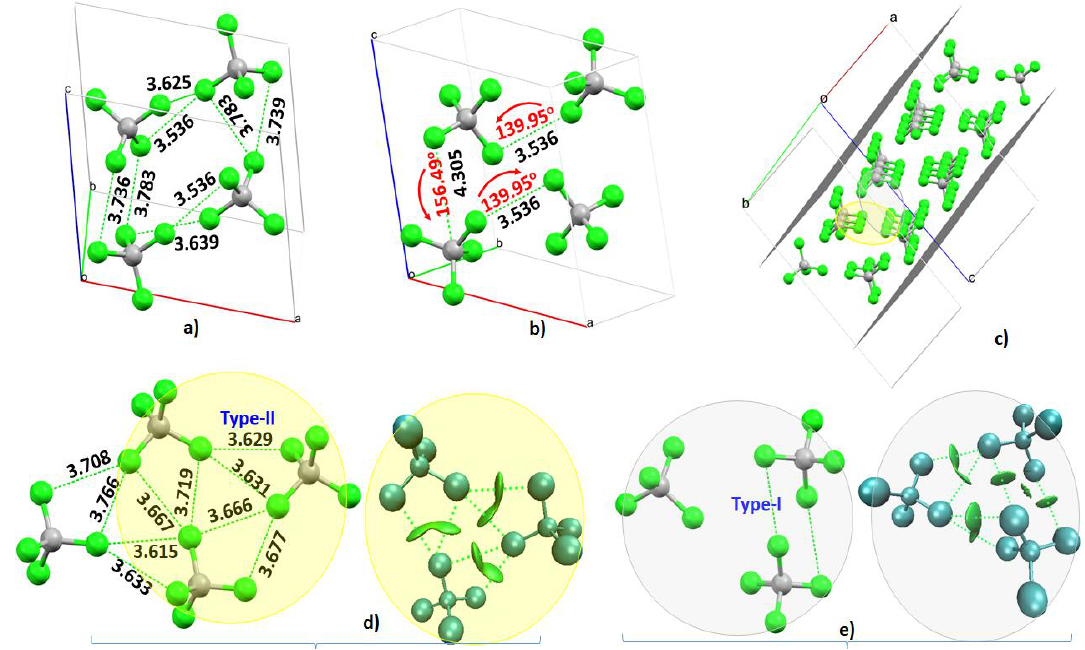
Figure 11. The ball-and-stick models of the ( a , b ) unit cell and ( c ) the (002) slicing pattern of the CCl 4 crystal (CSD ref code: CARBTC07). The triangular windmill-type intermolecular bonding topology is illustrated in ( d ), whereas the interlayer Type-I topology between the Cl atoms of the interacting monomers in the crystal is shown in ( e ). The 0.005 a.u. isosurface plots corresponding to the geometries ( d , e ) are illustrated, and were obtained with the IGM analysis.